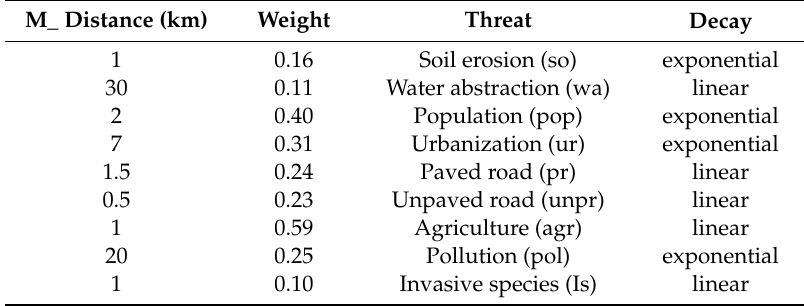
Table 4. Threat types, their weight, decay, and maximum impact distance in the Winike watershed.